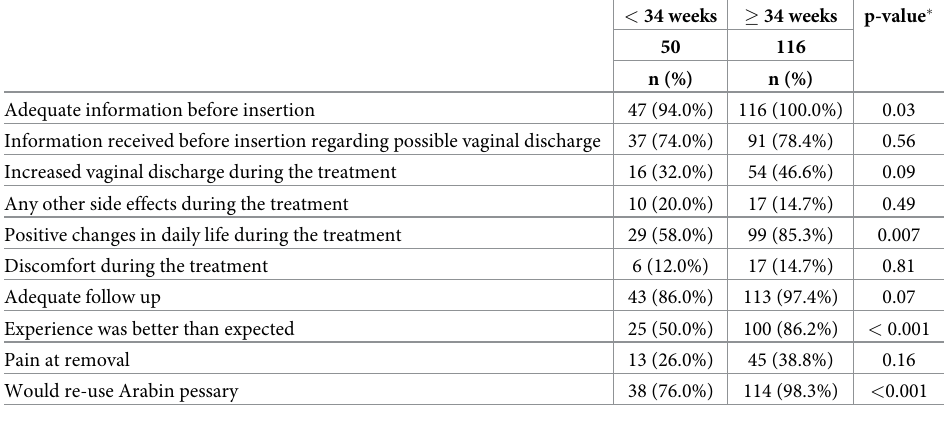
Table 3. Results of the subjective experience stratified for gestational age at delivery (before or after 34 weeks of